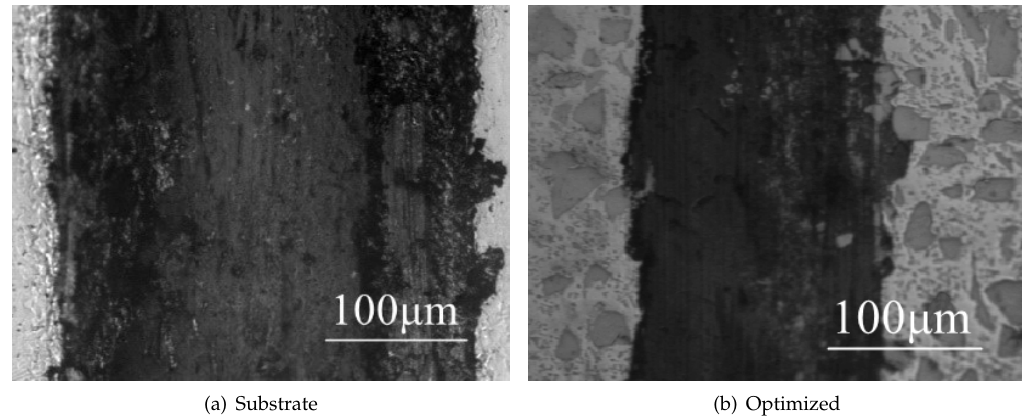
Figure 15. Comparison of 2D worn morphologies of substrate and optimized clad